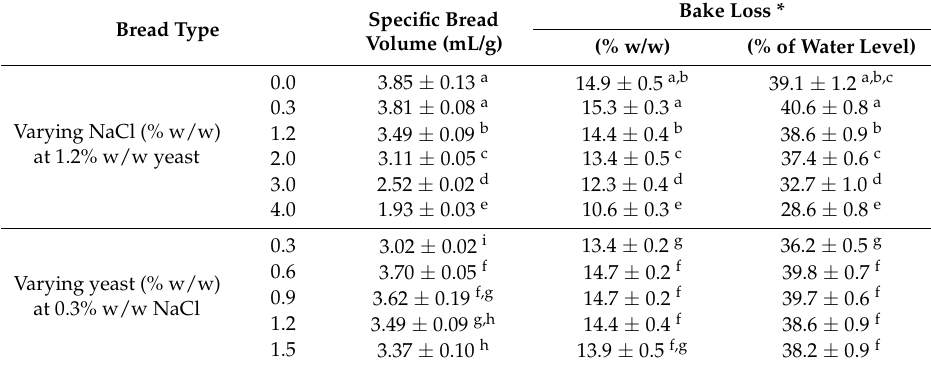
Table 3. Specific volume and bake loss of bread loaves with different NaCl concentrations and standard yeast level of 1.2% w/w and with different yeast concentrations and standard NaCl concentration of 0.3%